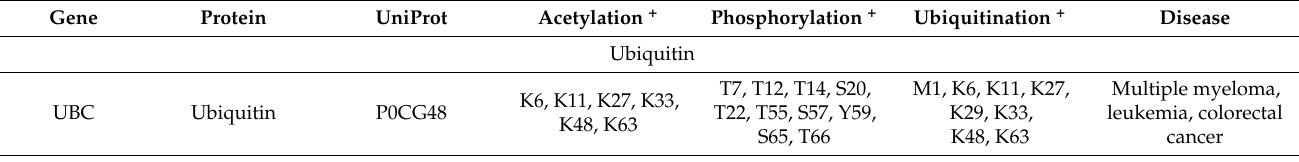
Table 1. Post-translational modification sites in human ubiquitination proteins #